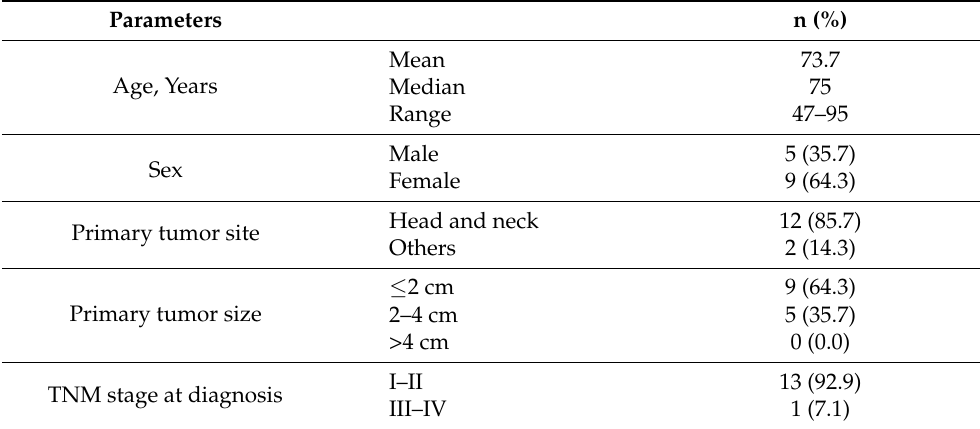
Table 1. Demographic data of 14 patients with sebaceous carcinoma.